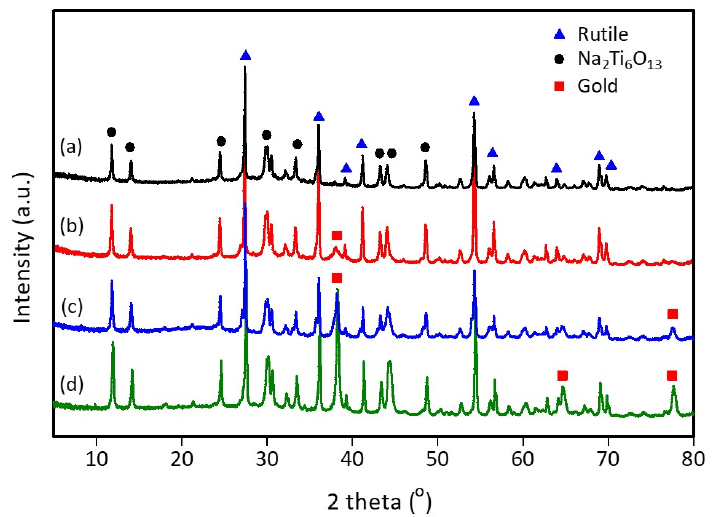
Figure 2. X-ray diffraction pattern ( a ) TiO 2 /NTO, ( b ) 1% Au/TiO 2 /NTO, ( c ) 2% Au/TiO 2 /NTO, and ( d ) 3% Au/TiO 2 /NTO. ( d ) 3% Au/TiO 2